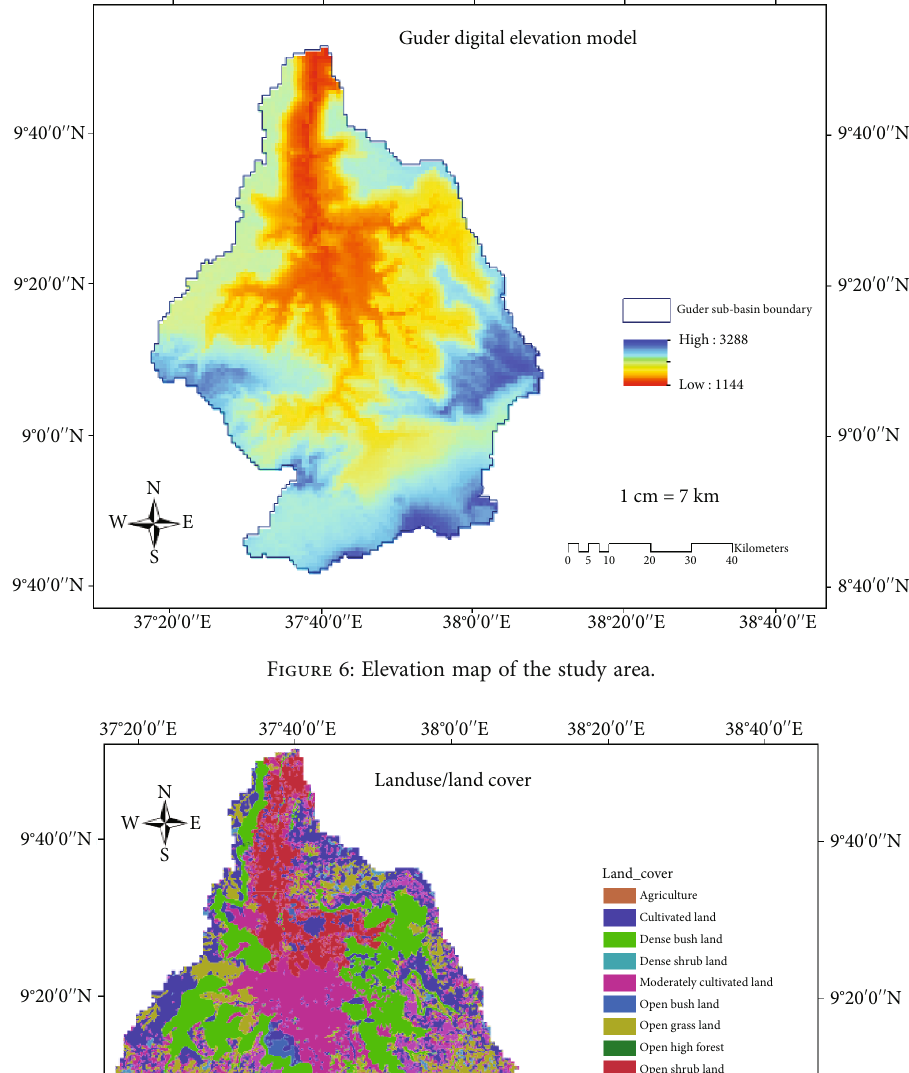
Figure 7: Land use/land cover of the study